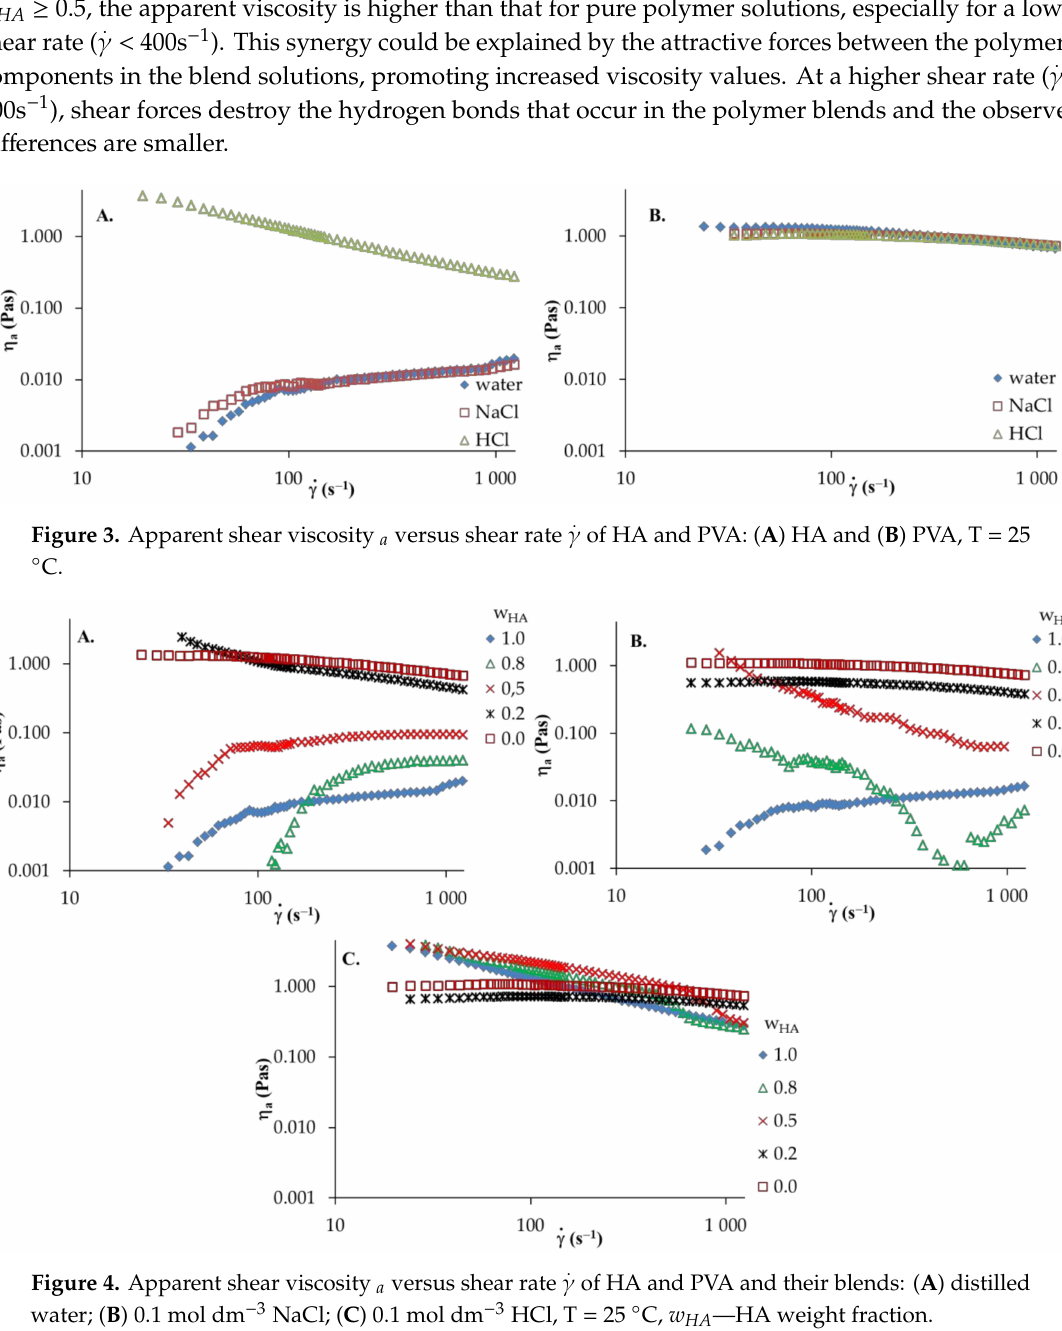
Figure 4. Apparent shear viscosity a versus shear rate